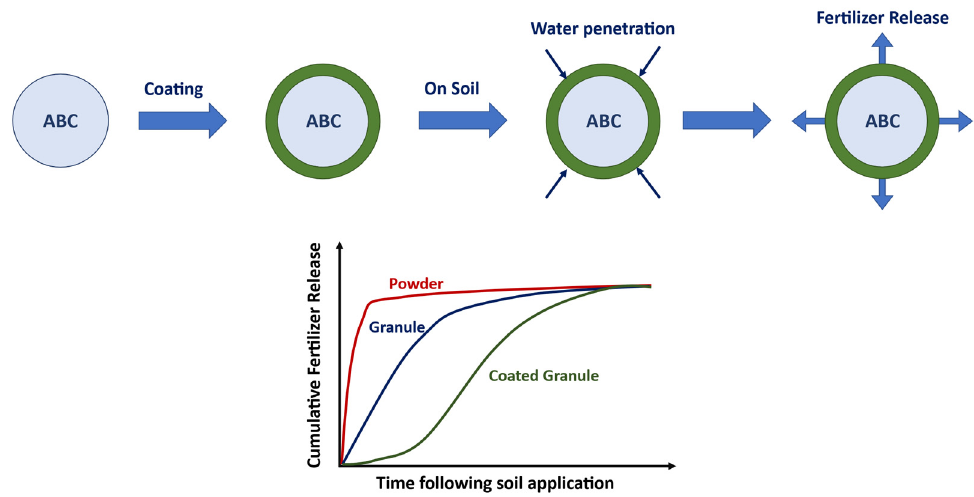
Figure 7. Schematic representation of coatings affecting nutrient release from ammonium bicarbonate fertilizers.